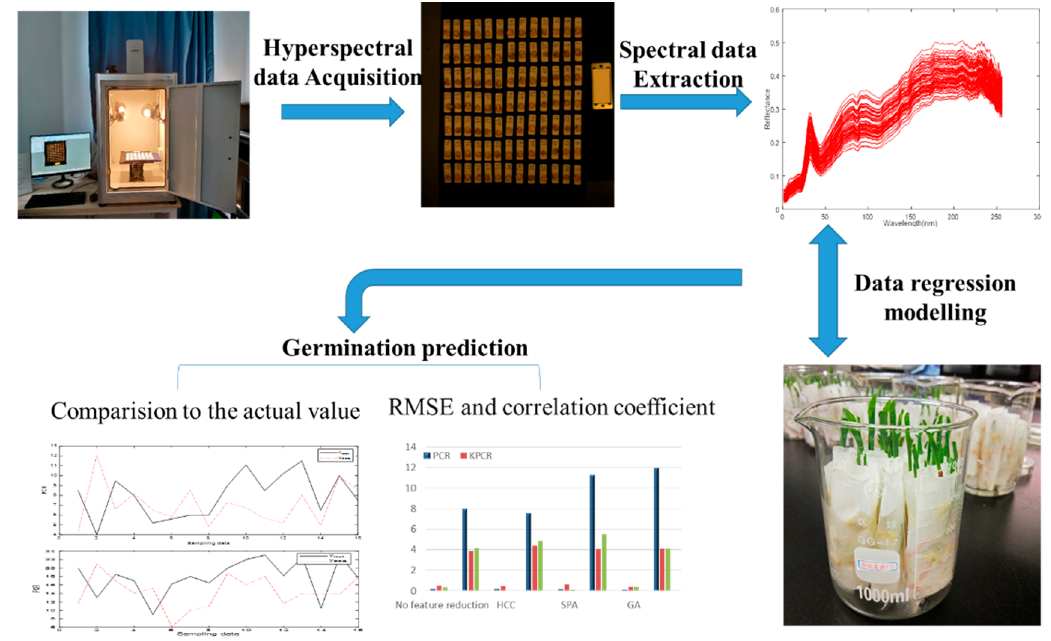
Figure 1. Schematic overview of the analytical procedure for the germination prediction of sweet corn seed.